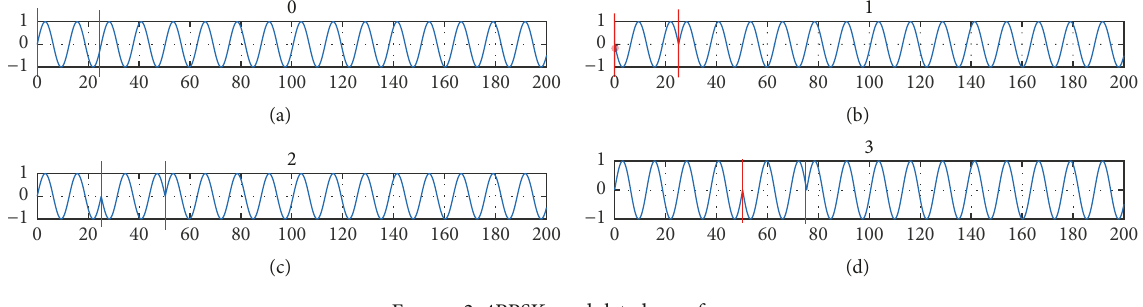
Figure 2: 4PPSK modulated waveforms.